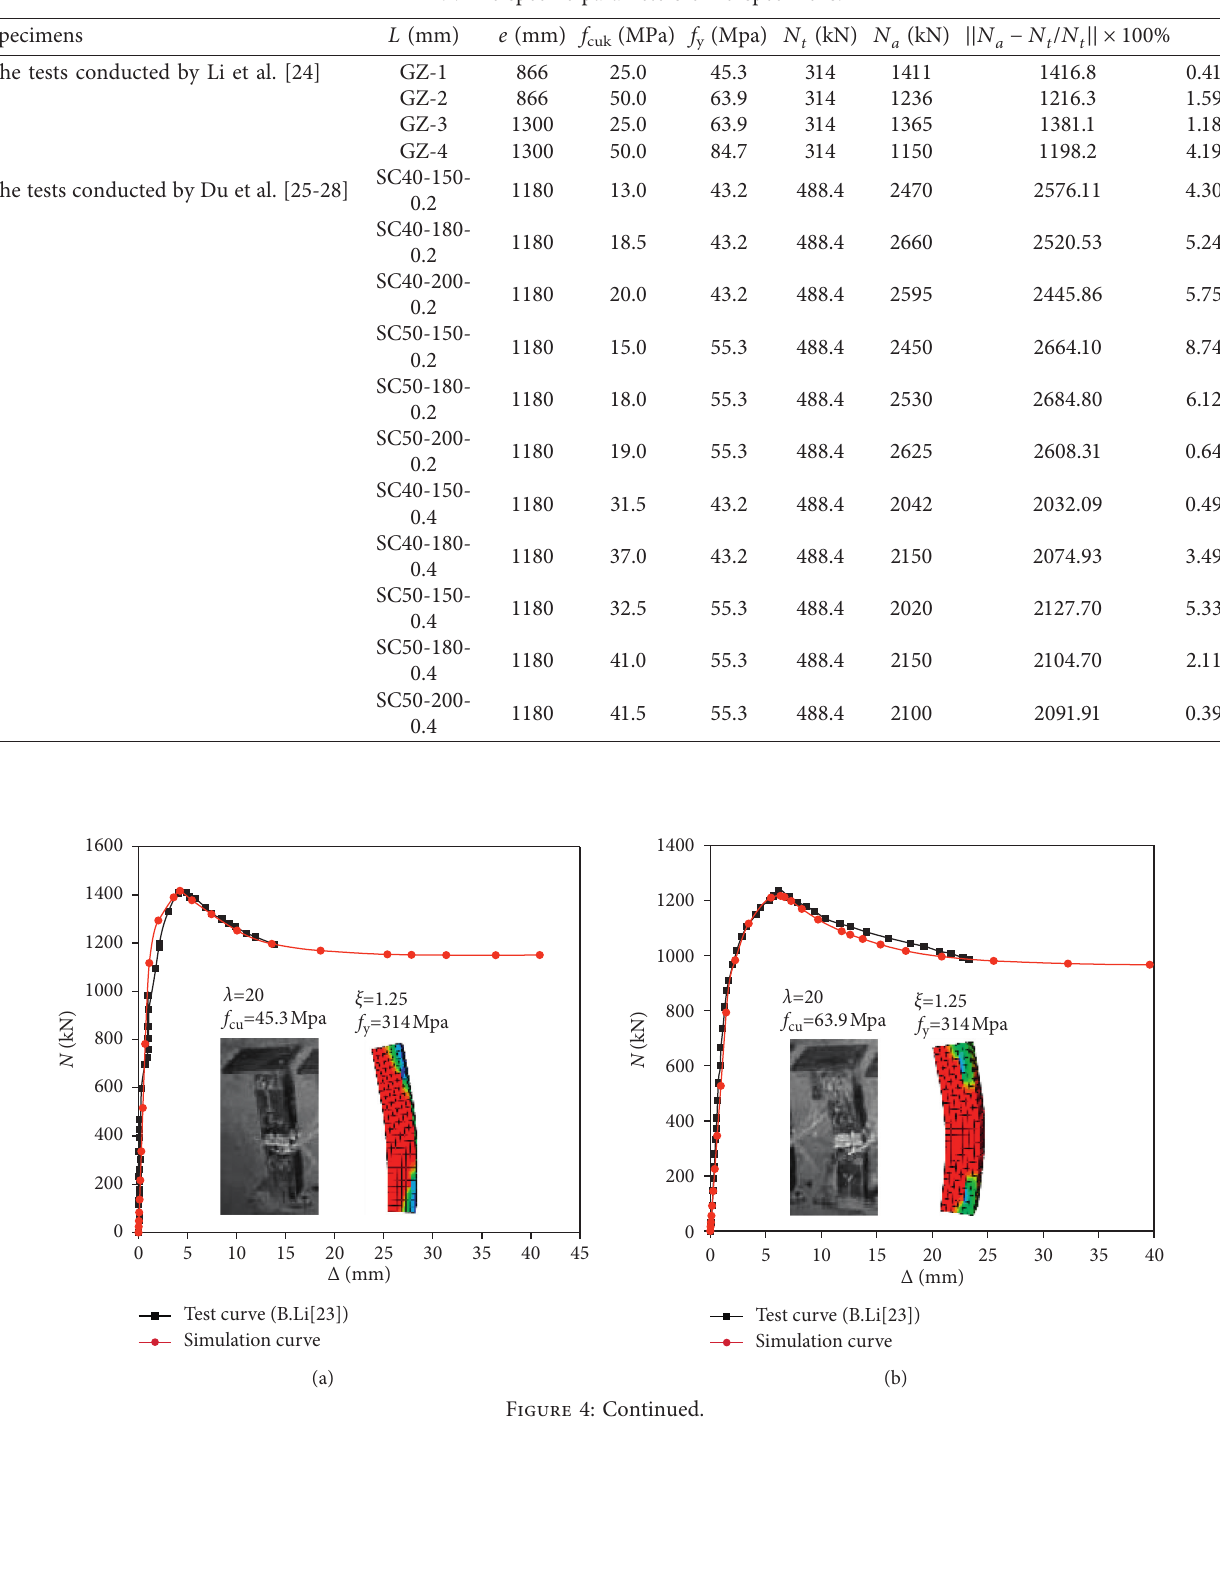
Table 2: : The specific parameters of 15